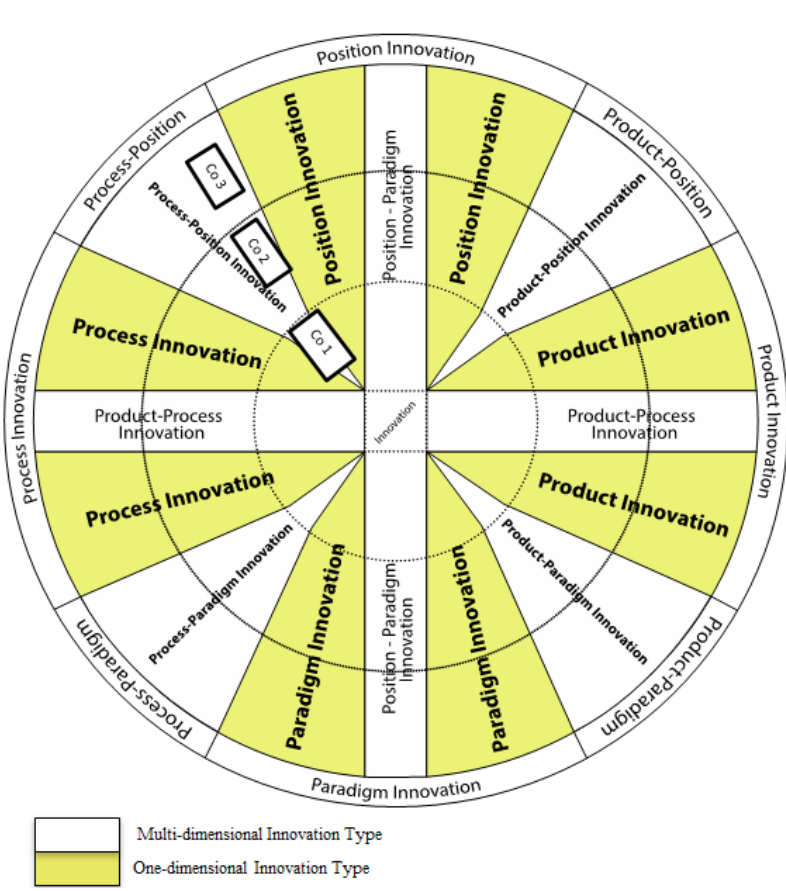
Fig. 2. 10Ps Benchmarking Innovation Mapping Model (Al-Abbas, 2014,